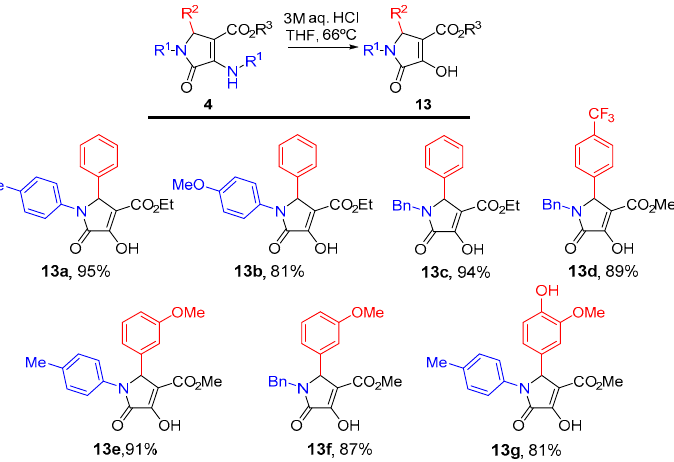
Figure 4. 3-Hydroxy 3-pyrrolin-2-ones 13 obtained.